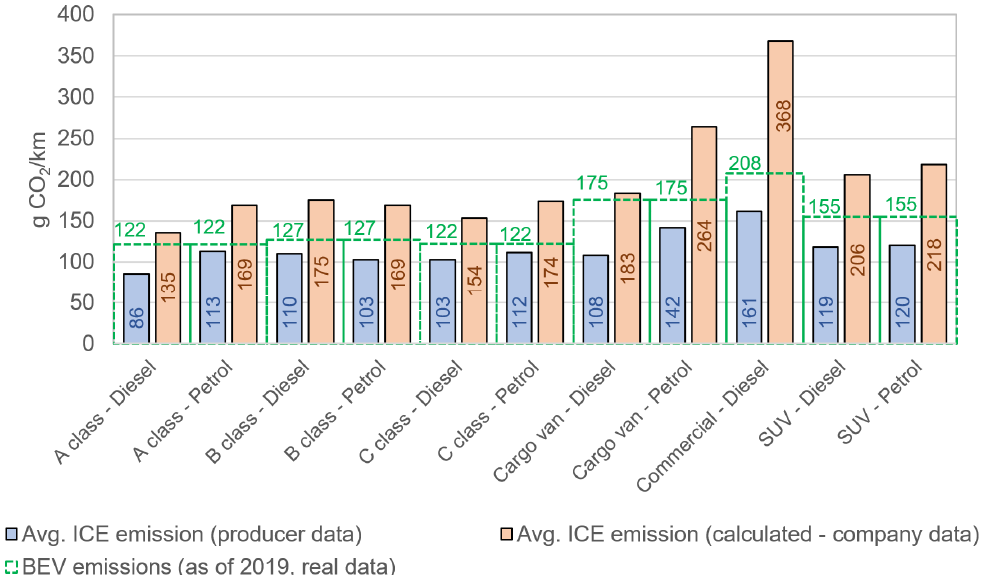
Figure 5. Comparison of carbon emissions (g CO 2 /km) of ICE and BEV cars—producers’ data, fleet-specific measurements and real usage data.